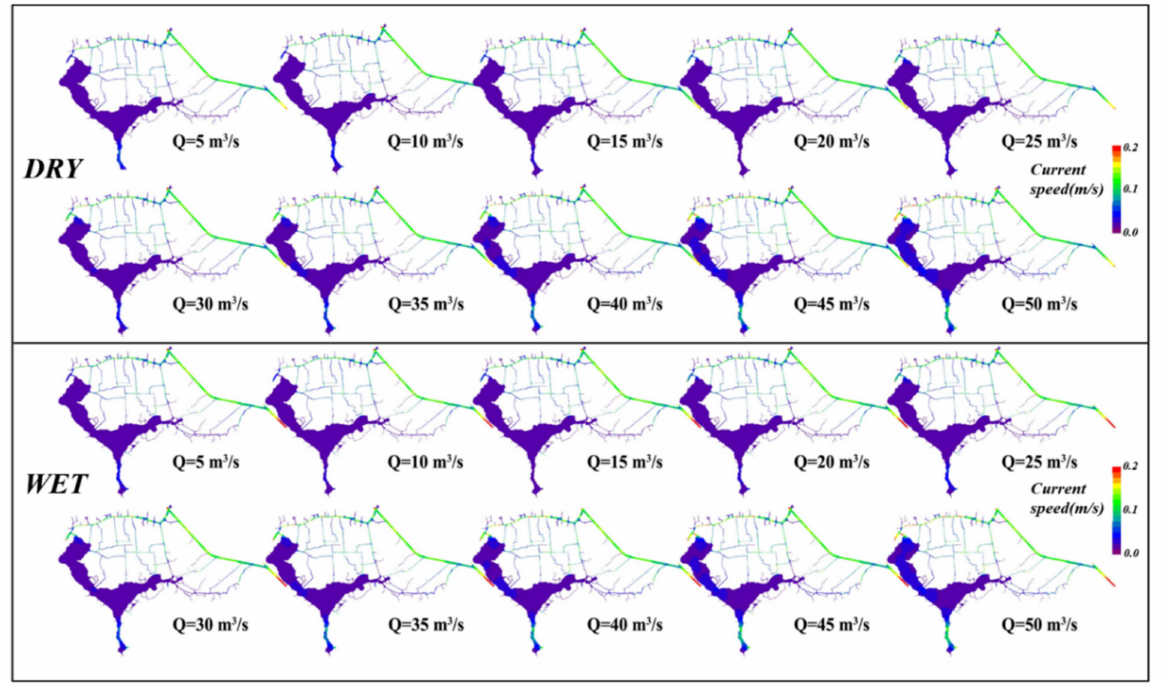
Figure 5. The velocity distribution of the lake-river network system under different water diversion flux in wet and dry